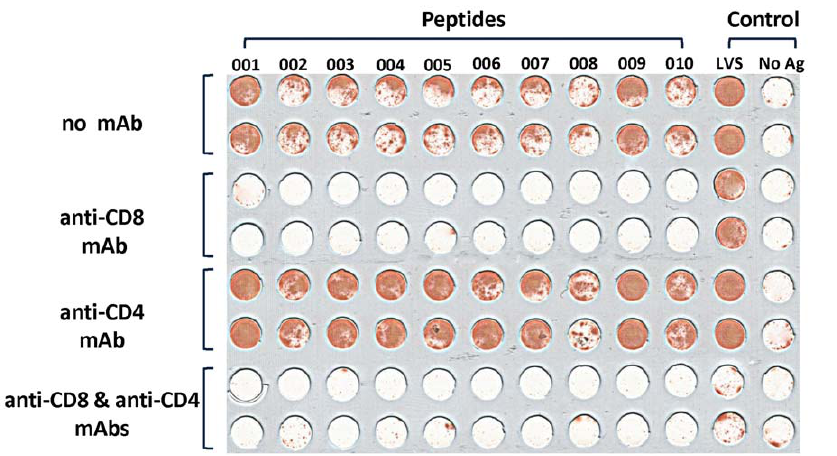
Figure 5. Effect of anti-CD8 and anti-CD4 antibodies on the T-cell response. A sample of over 20 EliSpot plates is presented, in which each of the first ten columns contains splenocytes incubated with an individual peptide and the last two columns are positive and negative controls, containing splenocytes incubated with formalin killed LVS ( LVS ) and splenocytes devoid of antigen ( No Ag ), respectively. Rows 1 and 2 (duplicates) contain splenocytes incubated with peptides denoted 001-010 (arbitrary numbering), or with LVS; the following pairs of rows (from top to bottom) are repeats of rows 1 and 2 supplemented with anti-CD8, anti-CD4 or a mixture of anti-CD4 and anti-CD8 antibodies. All 222 F. tularensis responder peptides exhibited the same behavior as depicted in the sample plate shown in this figure, with respect to the effect of anti-CD8 and anti-CD4 antibodies (see text and (Table S5)).